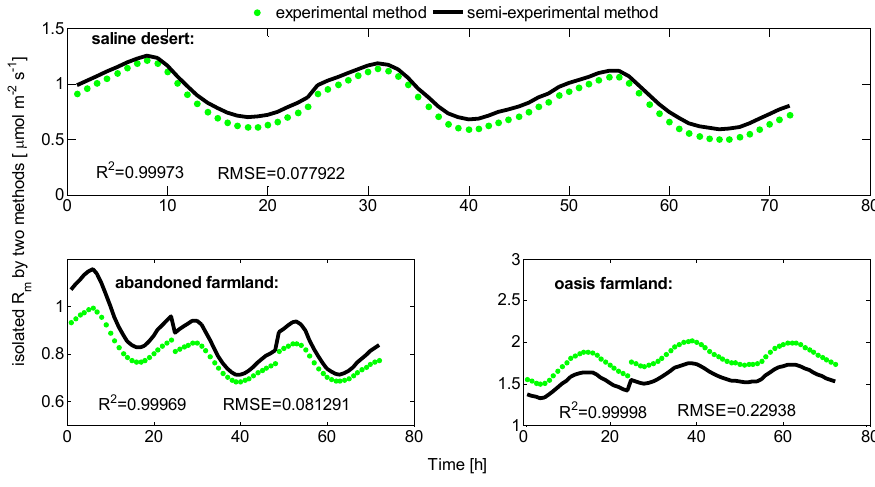
Figure 8. Cross validation of isolated R m by two methods.